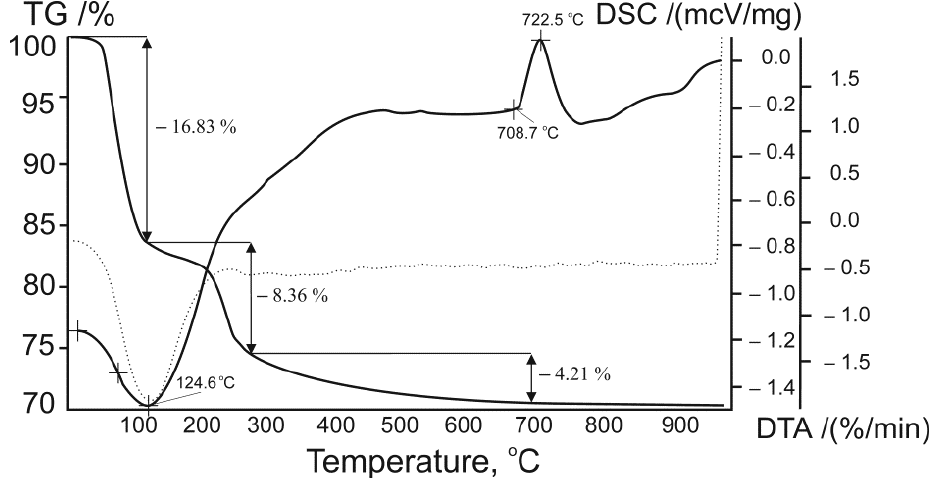
Figure 3. Thermogravimetric and differential scanning calorimetric (TG-DSC) data for obtained titanium phosphate.